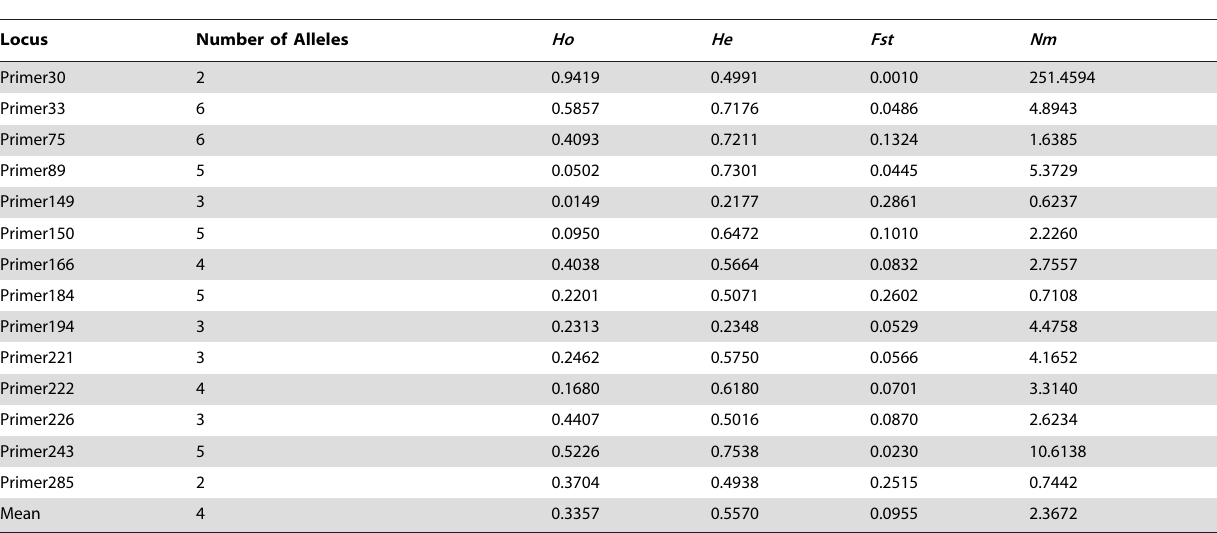
Table 2. Genetic parameters associated with each of the 14 EST-SSR primers.